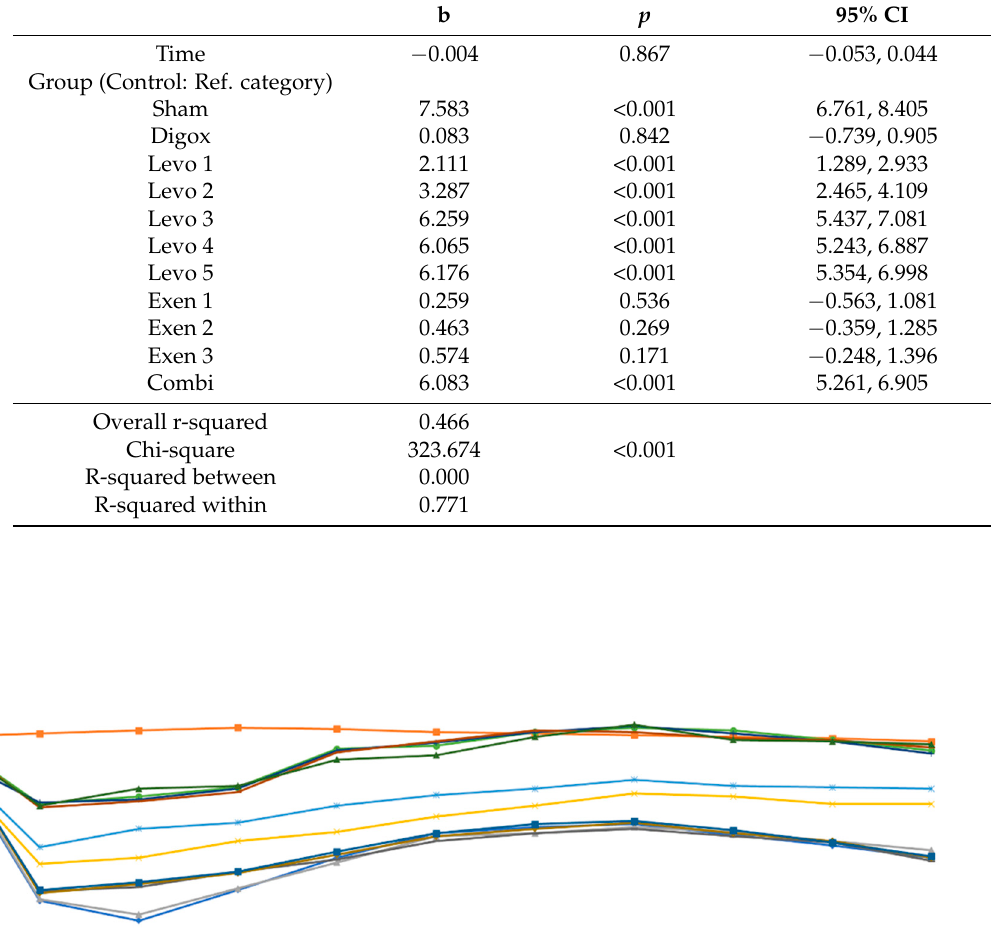
Table 8. Longitudinal analysis for coronary flow for all groups.